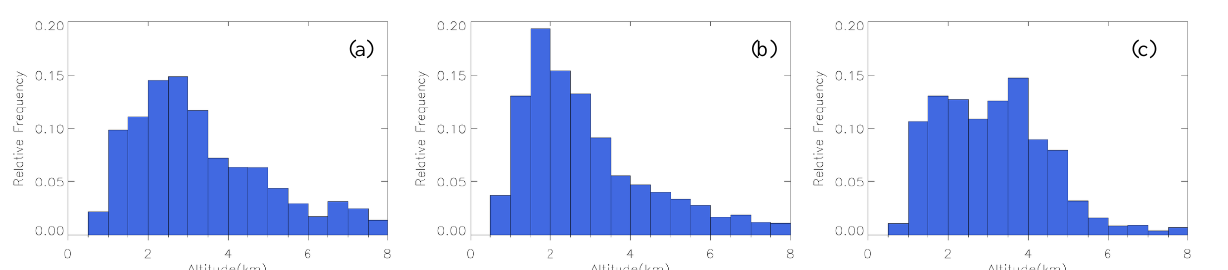
Figure 2 Histogram of layer top altitudes of aloft anthropogenic aerosols derived from CALIPSO satellite over (a) central-eastern China, (b)NCP and (c)YRD for winters 2007–2016. variation in the proportion of three months in winter. However, different distributions are indicated in the YRD area as shown in Figure 4b. First, in December and January of the following year, the ratio of polluted dust to smoke is 6 to 4 which is a huge difference from the ratio of 4 in the NCP region. Second, in January, the proportion of smoke and polluted dust was comparable.